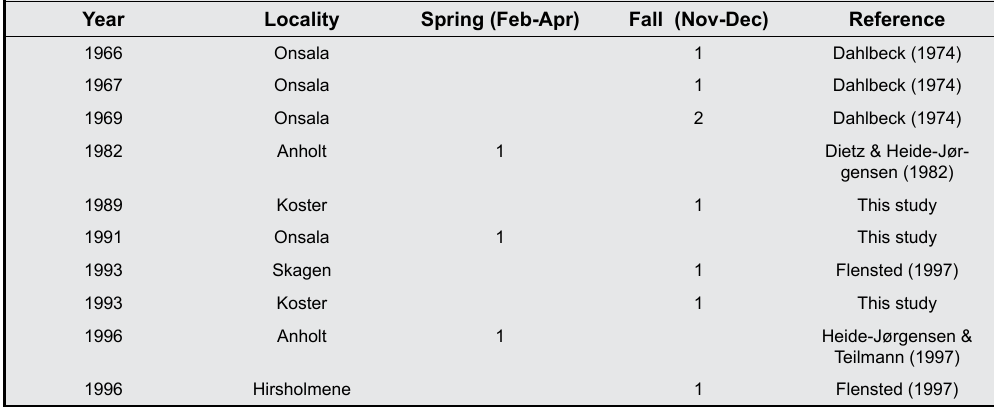
Table 1. Occurrence of pups born in the spring (suggesting Baltic origin) or fall-winter (suggesting Atlantic origin) in the Kattegat-Skagerrak since